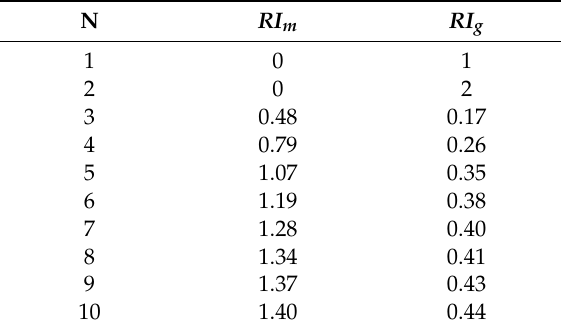
Table 5. RI for each matrix.